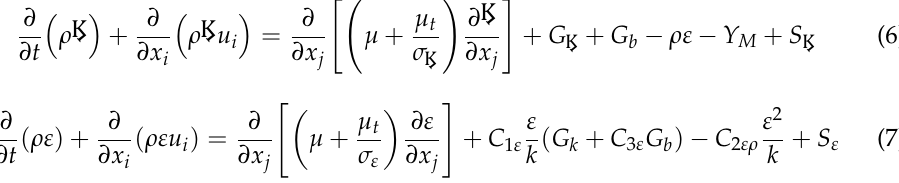
Figure 2. Lattice heat sink mesh.